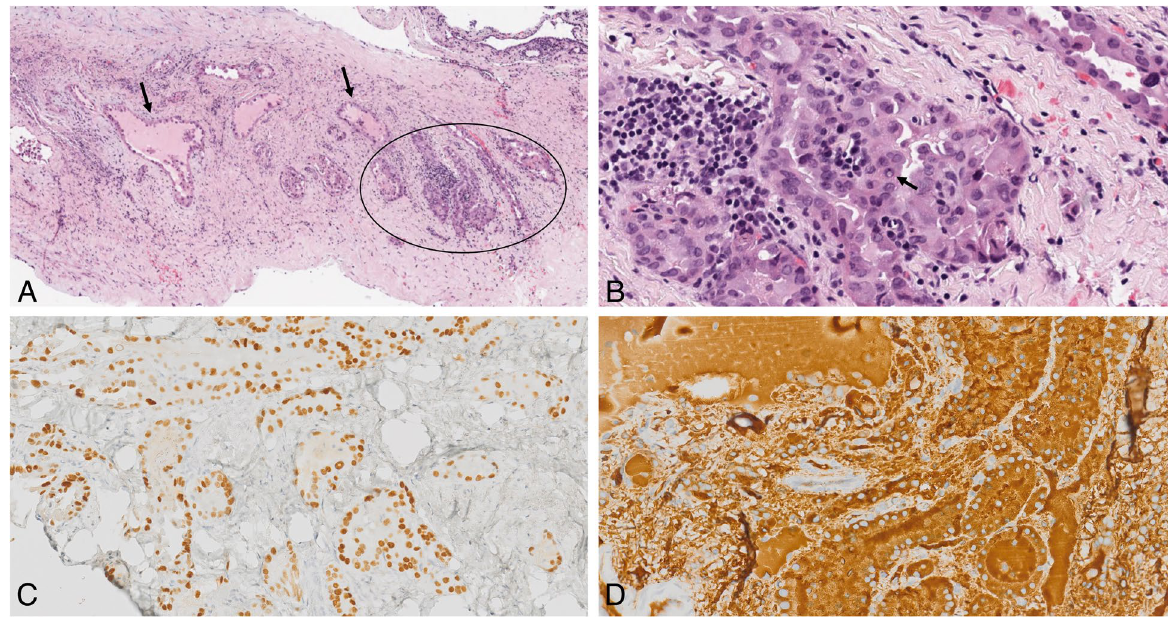
Fig. 1 Malignant Struma Ovarii. A Low power view (0.4x) of H&E section from the left ovary shows thyroid follicles of various sizes and shapes embedded in an inflamed fibrotic stroma. Note the malignant aggregate of thyroid tissue (circled) and adjacent poorly formed thyroid follicles (arrow). B High power image (20x) of the malignant component with nuclear pleomorphism, nuclear overlapping, irregular nuclear contour, and nuclear pseudoinclusions (arrow). These cells are positive for TTF‑1 ( C ) and thyroglobulin ( D ). Magnification in panel C and D is demonstrated by a scale